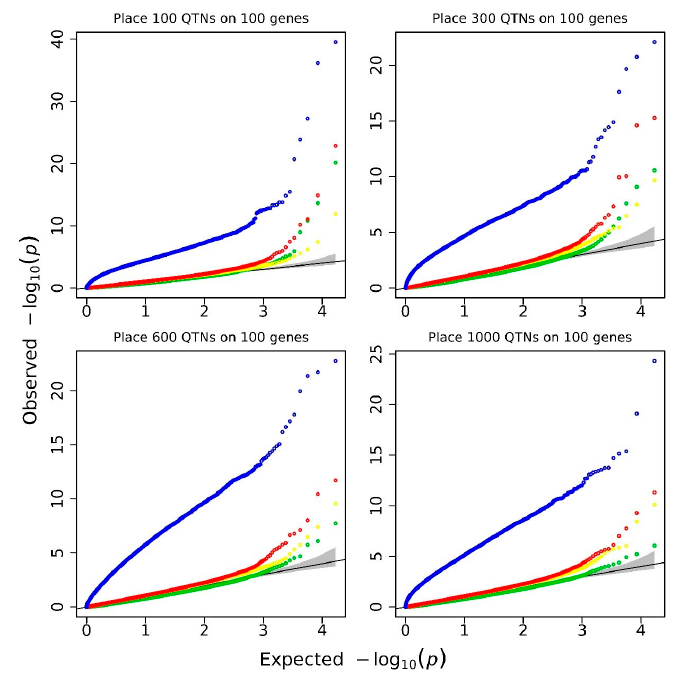
Figure 2. Q–Q plots for groups of 100, 300, 600, and 1000 QTNs. The green color represents ALLSNP, yellow represents FPC, red represents EPC, and blue represents EPCLM.